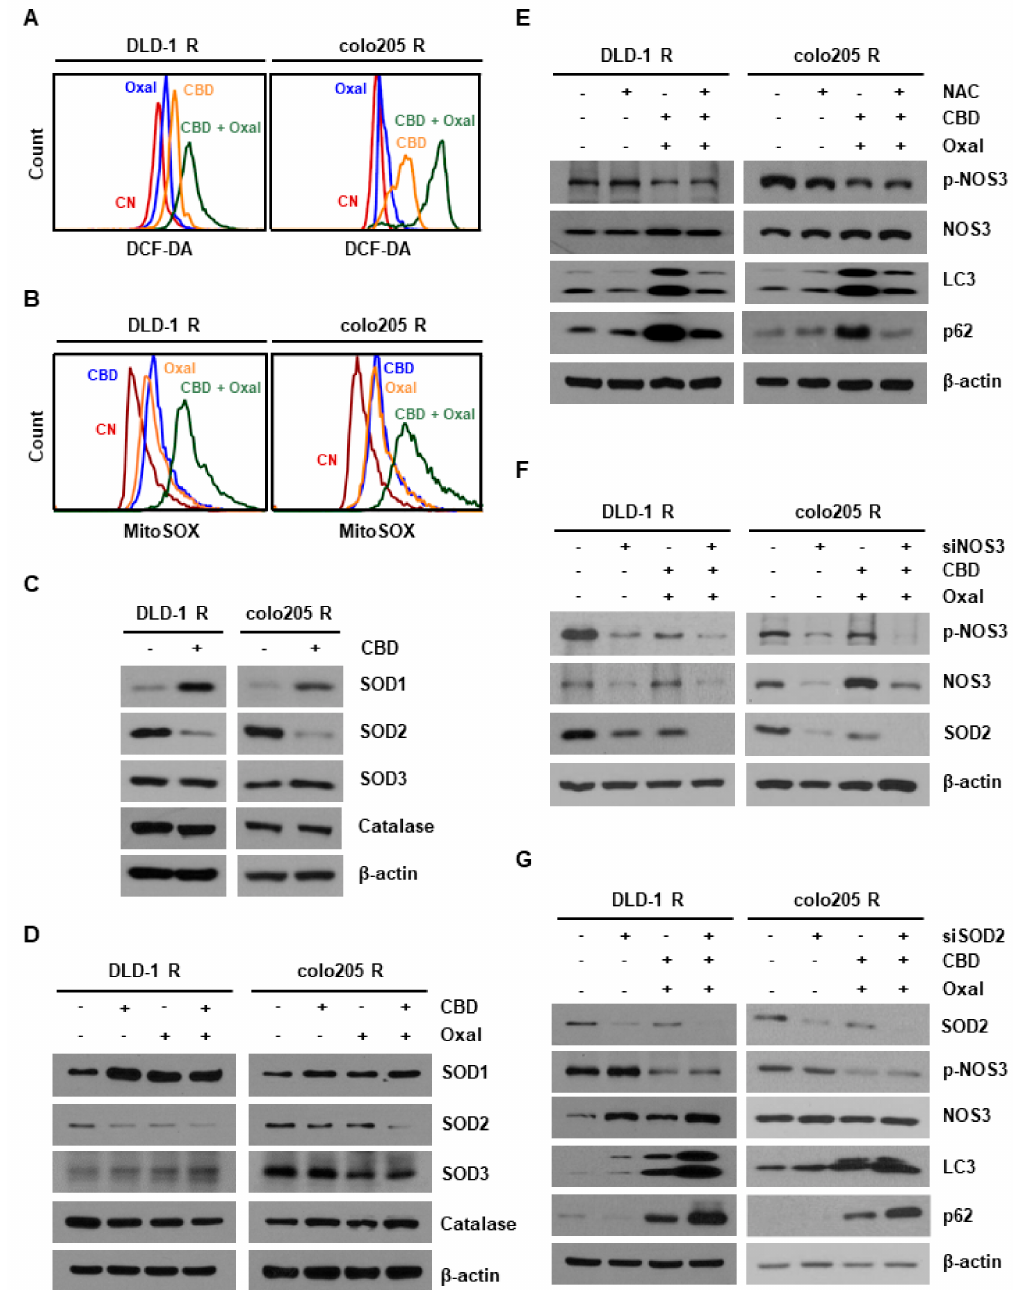
Figure 3. Combined treatment with oxaliplatin and CBD induces reactive oxygen species (ROS) via SOD2 inhibition. ( A , B ) Cells were treated with oxaliplatin and CBD for 24 h. Treated cells were then stained with ( A ) 10 µ M 2’,7’-dichlorodihydrofluorescein diacetate (DCF-DA) or ( B ) 5 µ M mitochondrial superoxide indicator (MitoSOX) for 10 min at 37 ◦ C. Stained cells were harvested and analyzed by flow cytometry. ( C ) Cells were treated with 4 µ M CBD for 24 h and antioxidant protein levels were then measured by western blotting. ( D ) Antioxidant protein expression was determined by western blotting in DLD-1 R and colo205 R cells treated with oxaliplatin and CBD. ( E ) Cells were pretreated with 5 µ M N-acetyl cysteine (NAC) for 1 h and then treated with oxaliplatin and CBD for 24 h. Cell lysates were analyzed by western blotting. ( F , G ) Cells were transfected with a ( F ) SOD2 or ( G ) NOS3 siRNA. Transfected cells were treated with oxaliplatin and CBD for 24 h and the protein levels of SOD2, NOS3, p-NOS3, LC3, and p62 were determined by western